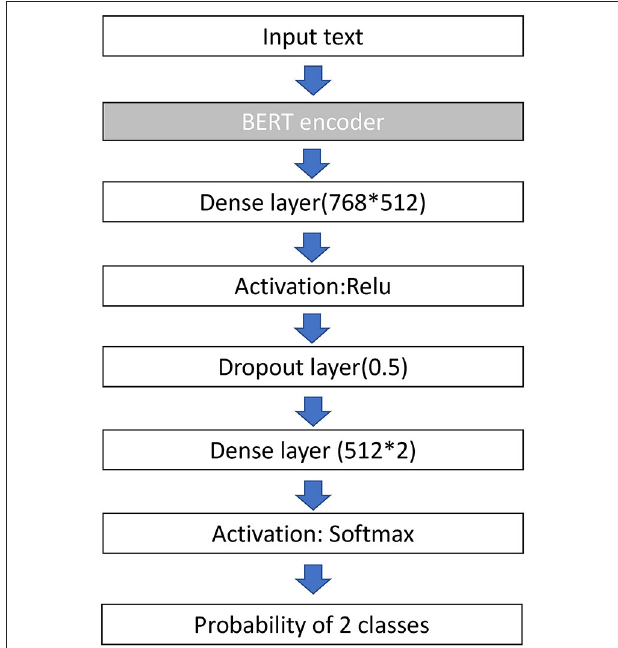
FIGURE 1 | Architecture of the BERT model used in this study. BERT, bidirectional encoder representations from transformers; ReLu, rectified linear